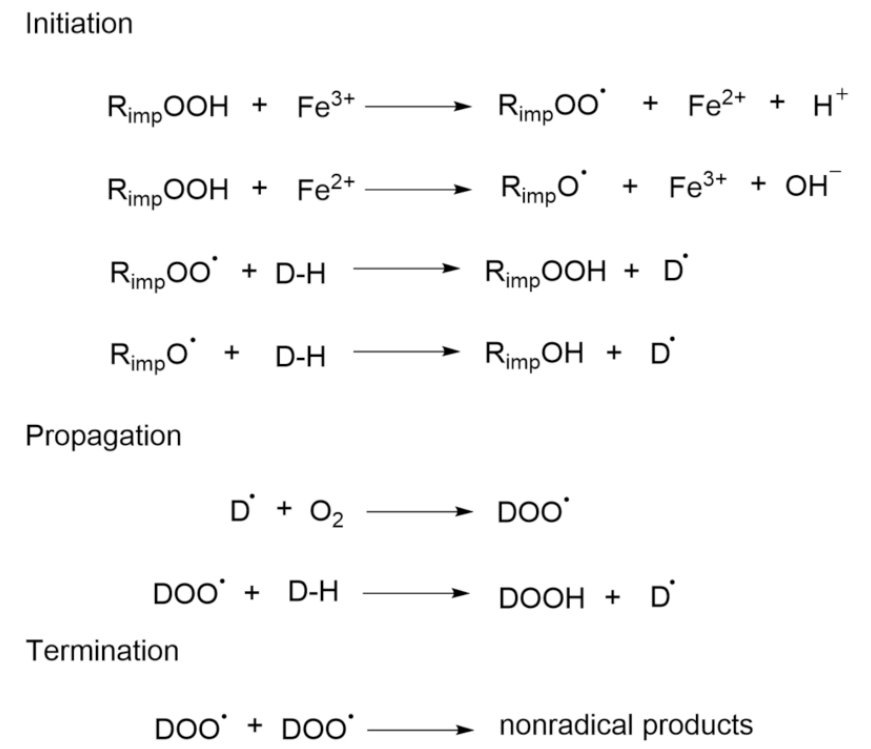
Figure 3. Autoxidation that is mediated by a drug-based peroxy radical (DOO •